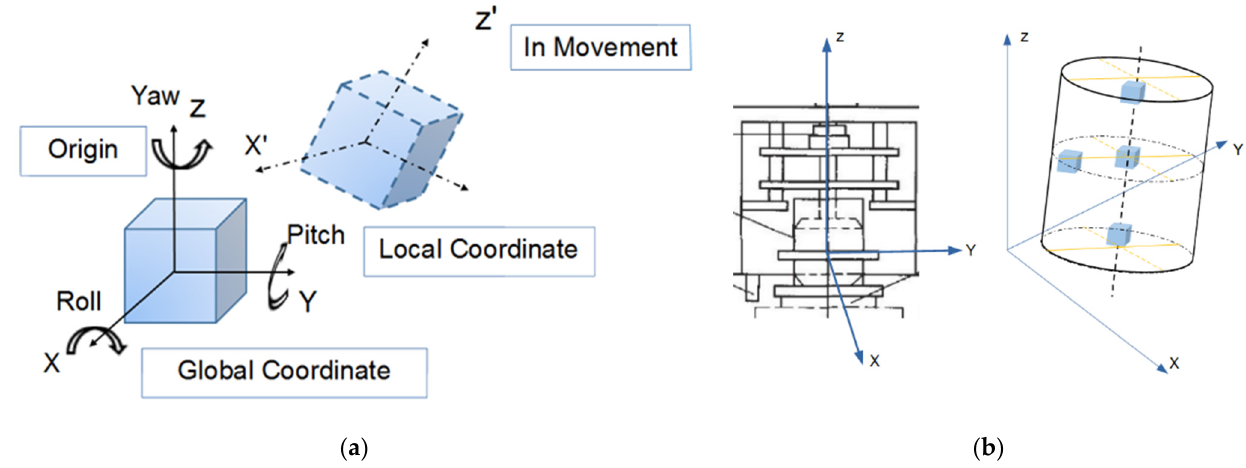
Figure 5. Illustration of ( a ) the two coordinate systems built in SR sensors and ( b ) placement locations of SR sensors within gyratory specimens.